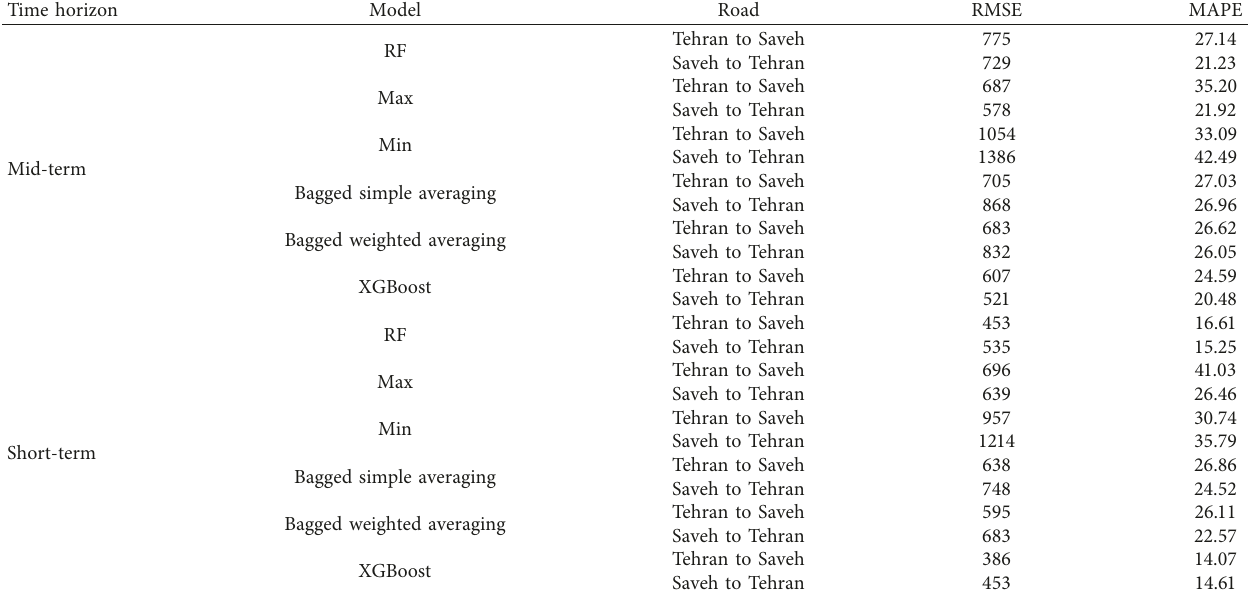
Figure 5: RMSE of short-term and mid-term models. (a) Saveh to Tehran. (b) Tehran to Saveh. Table 5: Error metrics for the ensemble learning methods and the most accurate base